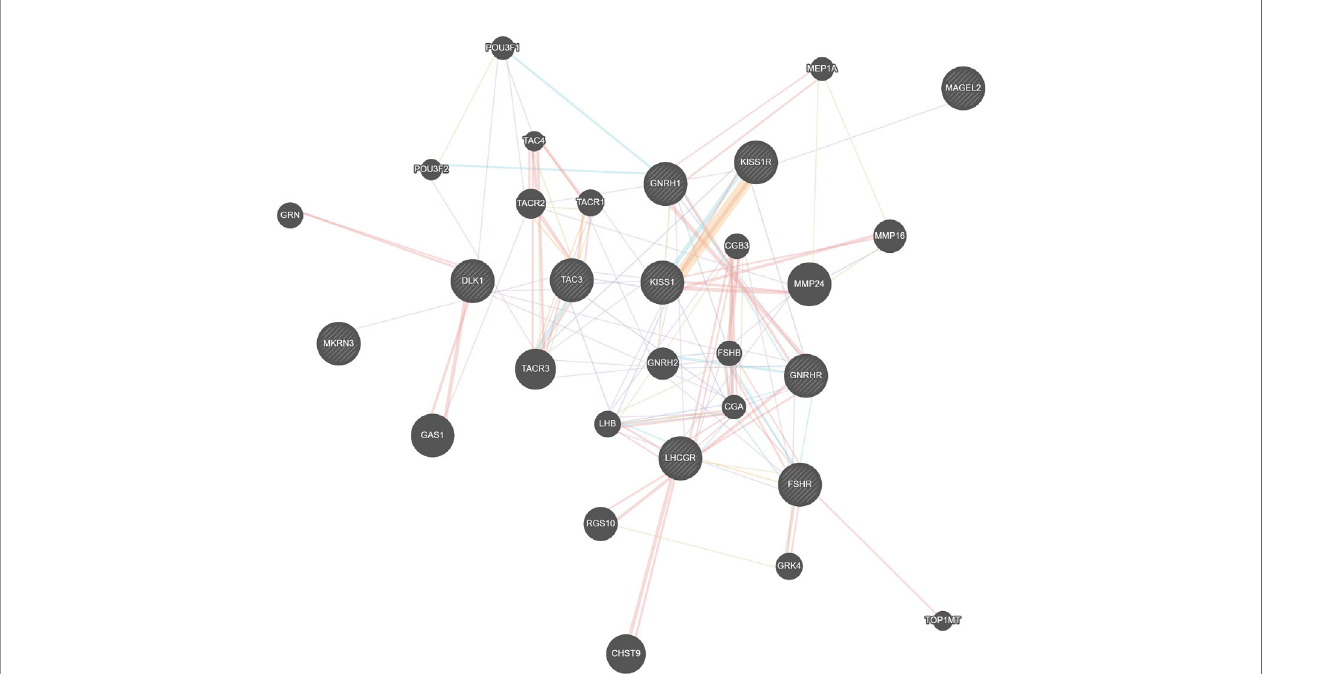
FIGURE 2 | Genetic network modeling for the MKRN3 gene in a holistic regulatory depiction of the crosstalk between MKRN3 and other